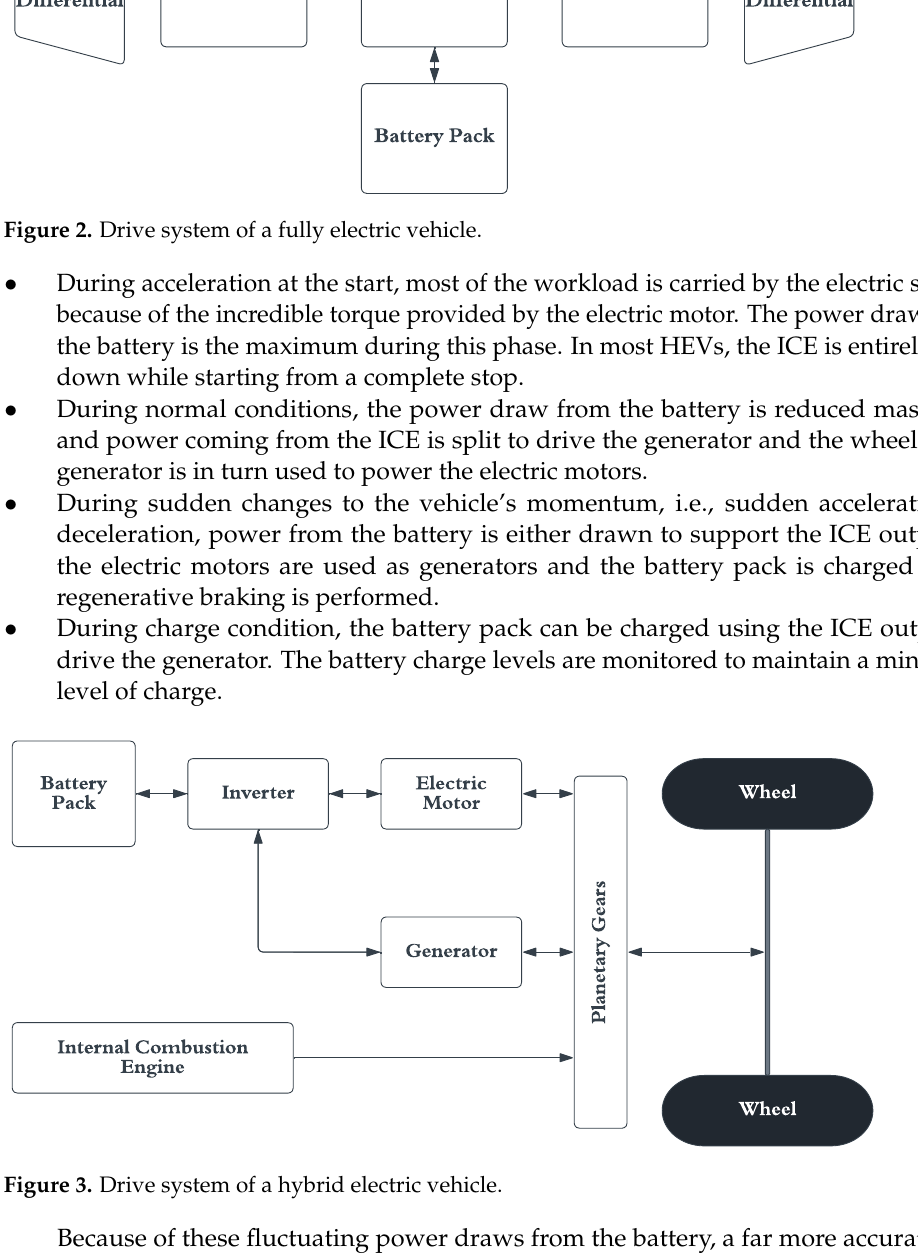
Figure 3. Drive system of a hybrid electric vehicle.